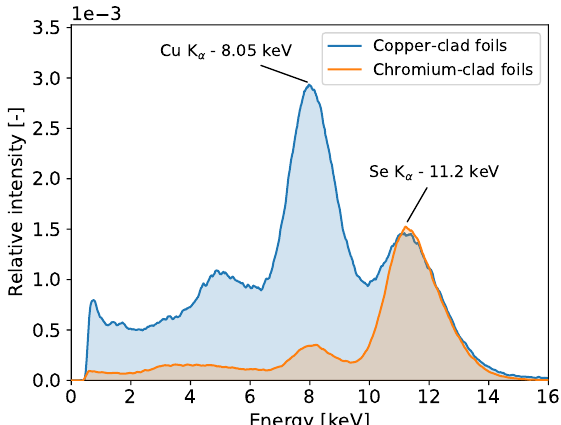
Figure 1. Spectra of selenium fluorescence obtained with the standard GEM detector with copper-clad foils and with the modified GEM detector using coper-less foils. One can observe large parasitic signal from excited copper-rich inner components of standard GEM detector in contrast to one with coper-less foils. The intensity is normalized to the area of the 11.2keV